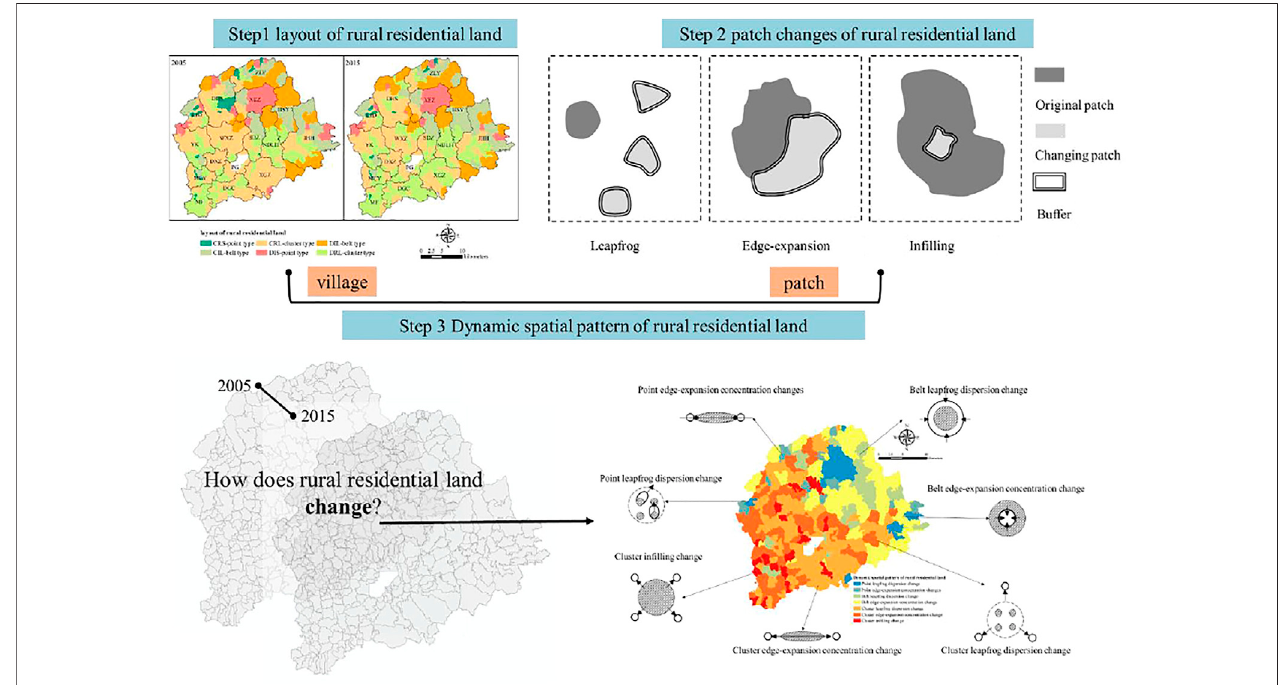
FIGURE 2 | Combination matrix method of the dynamic spatial pattern of rural residential land.